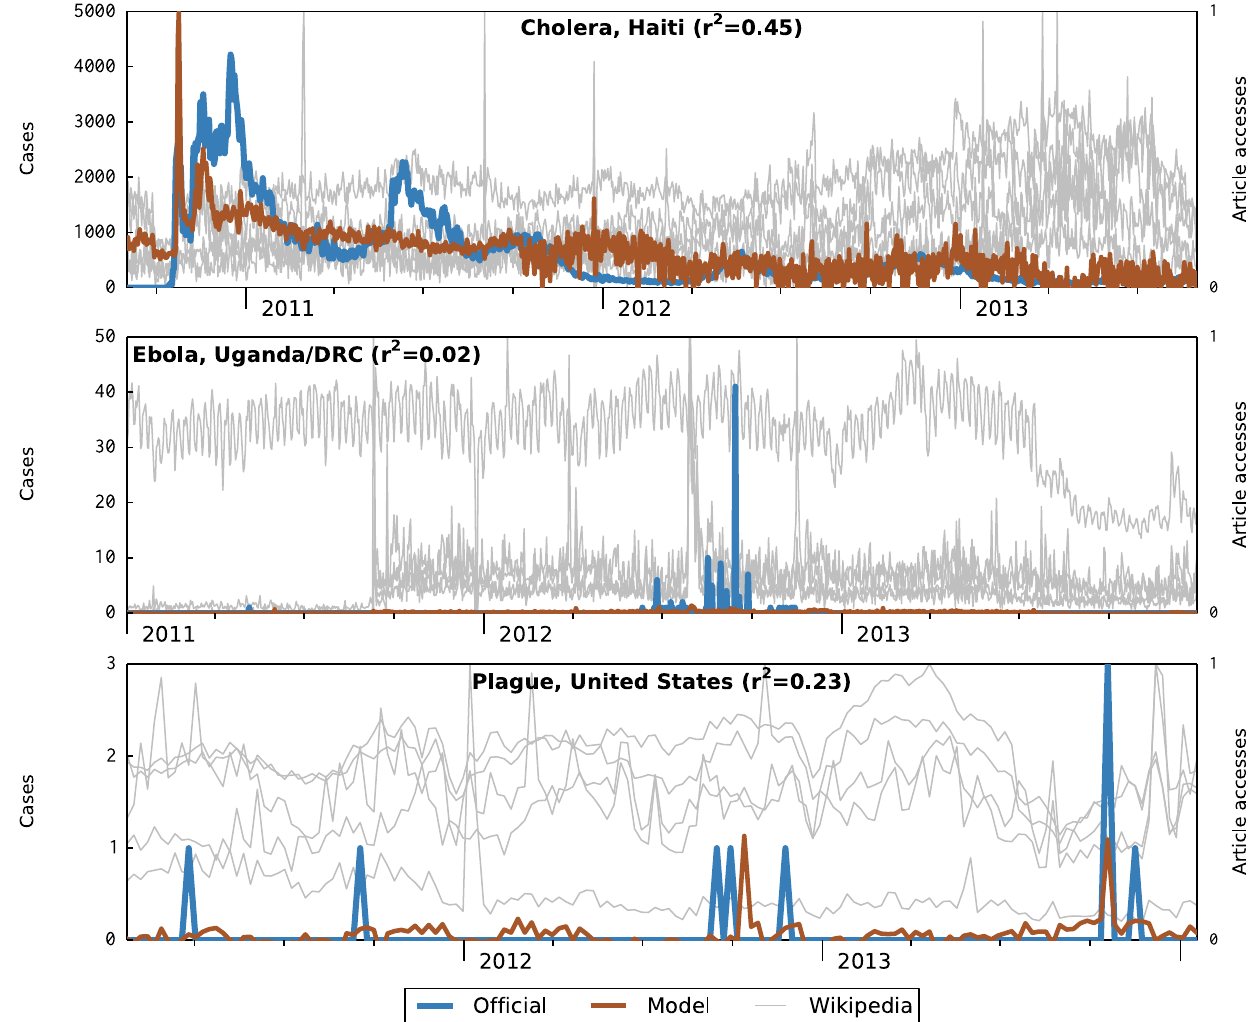
Figure 4. Nowcast attempts with poor performance due to unfavorable signal-to-noise ratio.